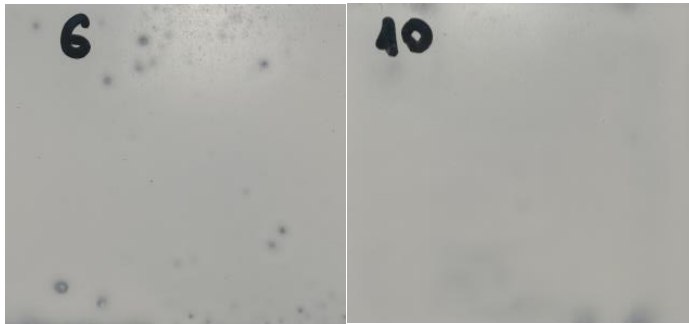
Figure 12. Photos of incorrect cleaning procedures.